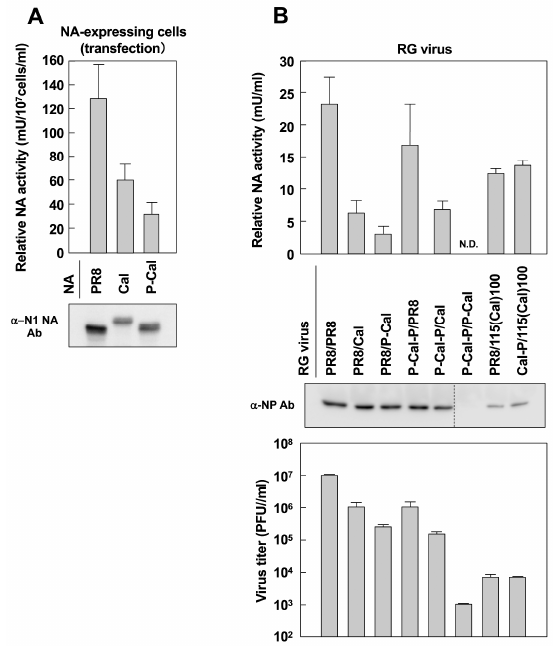
Figure 8. NA activities of chimeric NA and RG viruses and their infectious titers. 293T cells transfected with NA expression plasmids ( A ) and RG virus stocks ( B ) were lysed with 0.1% Triton X-100 and subjected to quantitative NA activity assay with fluorometric 4-MUNANA. Protein expression in cells and RG virus stocks were analyzed by Western blotting with anti-NA sheep Ab ( A ) and anti-NP rabbit Ab ( B ). The NA activity values were normalized to the expression levels of NA ( A ) and the levels of NP in RG viruses ( B ). Data were shown as means with standard deviations from three independent experiments. N.D.—not determined. The infectivity of RG virus stocks was measured by plaque assay in MDCK-SIAT1 cells.